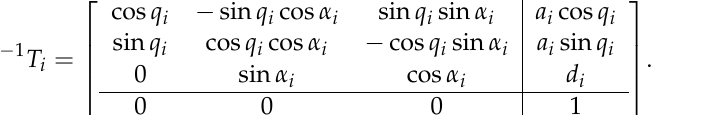
Figure 7. Gravity compensation mechanism for the motion tracker: ( a ) gravity compensation using